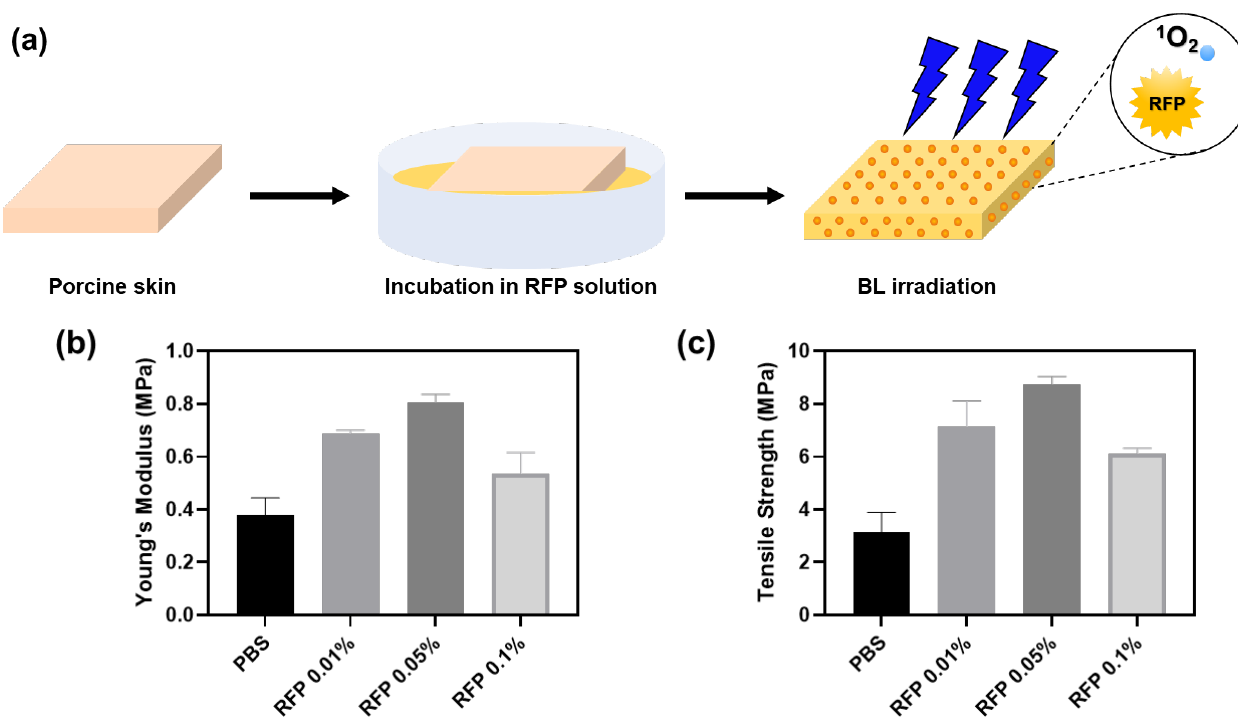
Figure 5. ( a ) Schematics of porcine skin elasticity enhancement by BL-activated RFP. ( b ) Young’s moduli and ( c ) tensile strengths of porcine skins after BL irradiation for 5 min with different RFP concentrations.